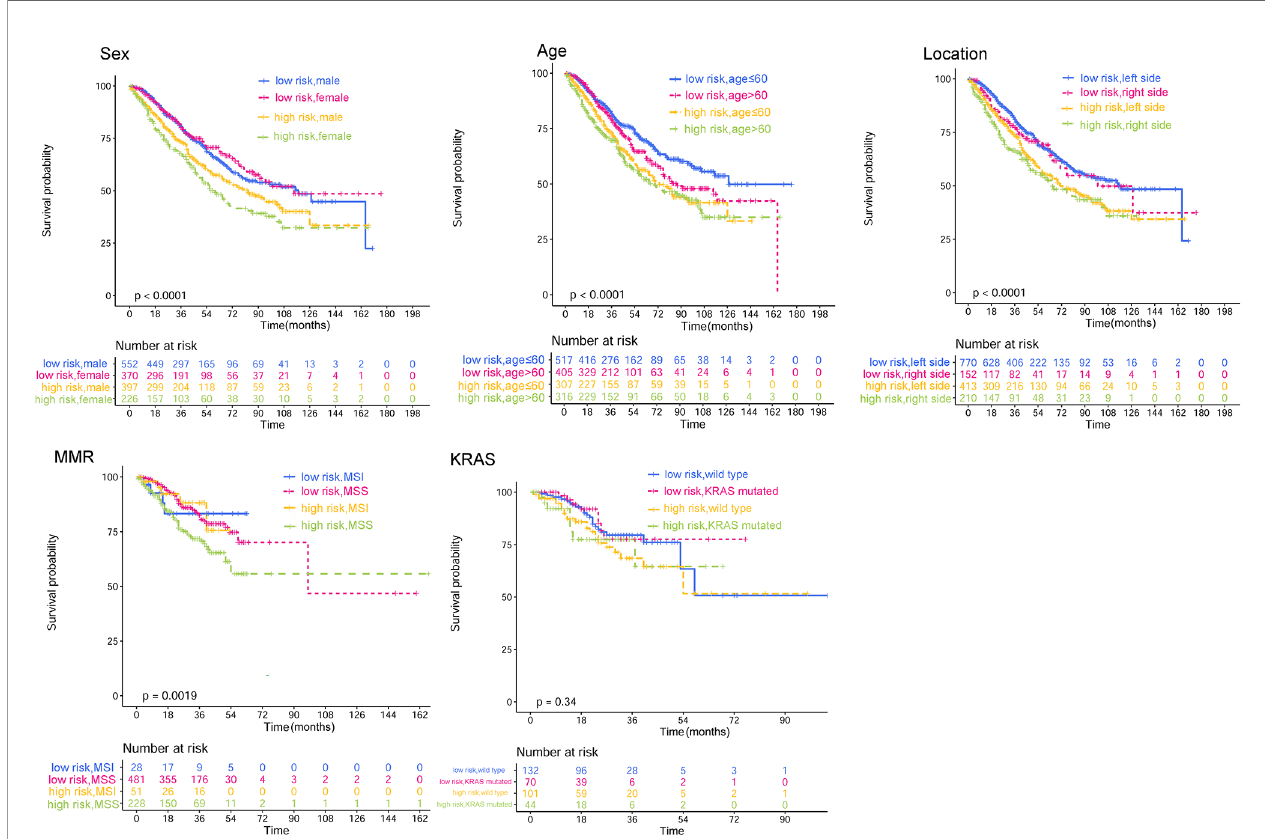
FIGURE 5 | Kaplan – Meier curves of subgroups based on CRP/MCV strati fi cation. The subgroup analysis types are displayed in the upper left corner of the graph, followed by sex, age location, microsatellite status, and KRAS gene type. A CRP/MCV value above 0.06 indicates high risk and vice versa. The abscissa represents time in months. CRP, C-reactive protein; MCV, mean corpuscular volume.